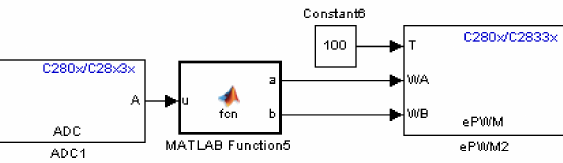
Figure 6. Control model of neutral-point potential.